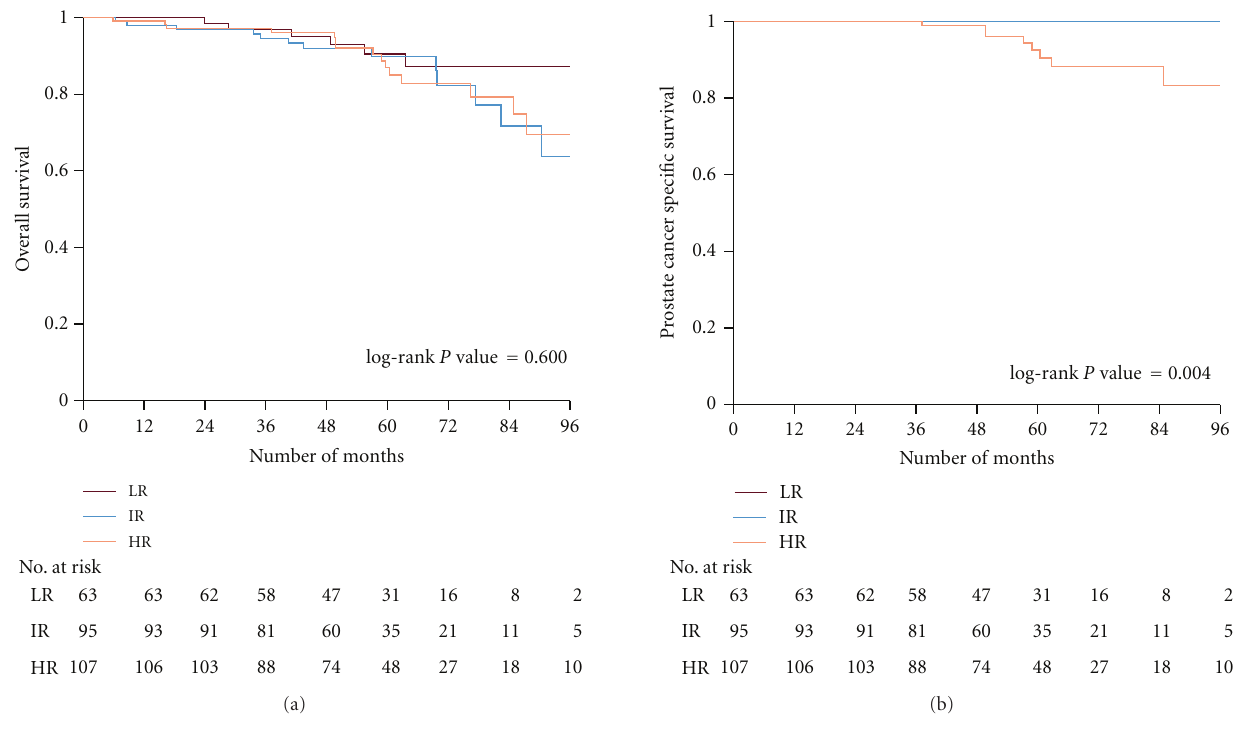
Figure 2: Kaplan-Meier curves illustrating the overall (panel a) and the prostate cancer-specific survival (panel b) of patients according to risk groups. The number of patients at risk is shown at di ff erent time intervals. LR: low risk, IR: intermediate risk, HR: high Risk.